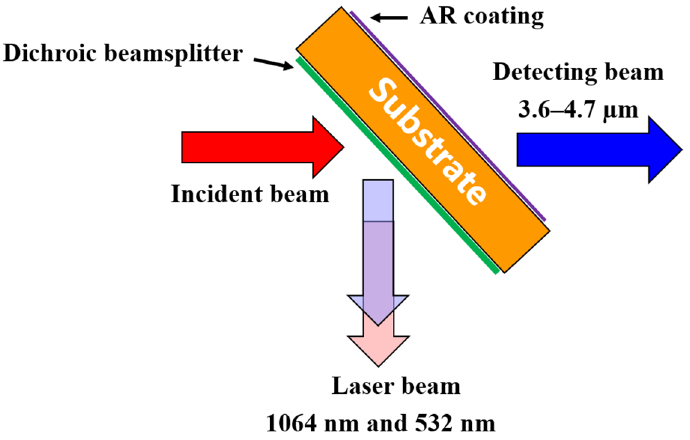
Figure 1. Schematic diagram illustrating the application of the dichroic beamsplitter in laser protec- tion process.